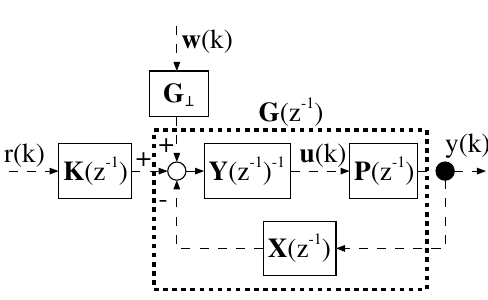
Figure 4. Block diagram of extended